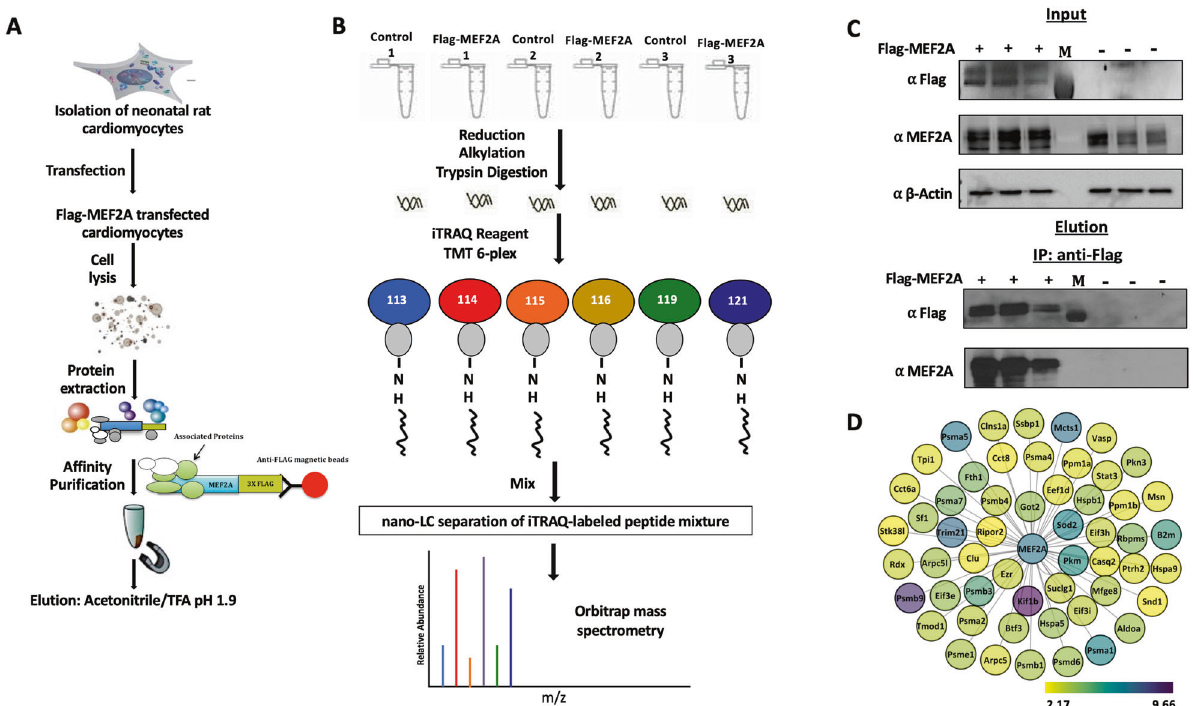
Fig. 1 Af fi nity puri fi cation and qualitative proteomic strategy to identify the Flag-MEF2A protein complex in PCMs. A PCMs are fi rst isolated and then transfected with a 3xFlag-MEF2A construct. The Flag-MEF2A complex was pulled down and puri fi ed using α -Flag magnetic beads. The beads were washed several times and the Flag-MEF2A complex was eluted with Acetonitrile/TFA pH 1.9. B Six independent samples of Flag-MEF2A lysates and non-transfected lysates were used to run six IPs. The elutes were trypsin digested and then labelled with iTRAQ reagents. Isobaric labelling reagents that produce reporter ions at m/z 117 and 118 were not used. The labeled peptides were separated using HPLC and then identi fi ed using MS/MS by relative quanti fi cation. C 3xFlag MEF2A and non-transfected lysates were subjected to Western blotting to indicate protein expression (Top panels). Six separate IP experiments were performed with α -Flag-magnetic beads then eluted and blotted with anti-Flag and MEF2A antibodies to con fi rm the AP step. IP with lysates from non-transfected PCMs were used as negative controls. M is an indication of the loading of the marker lane (Bottom panels). D 56 proteins in the Flag-MEF2A complex identi fi ed by mass spectrometric analysis. The node color corresponds to fold enrichment of the Flag-MEF2A interacting proteins in the three replicates, as de fi ned in the legend. The node position and edge length are arbitrary. The bait (Flag-MEF2A) is represented inside a black